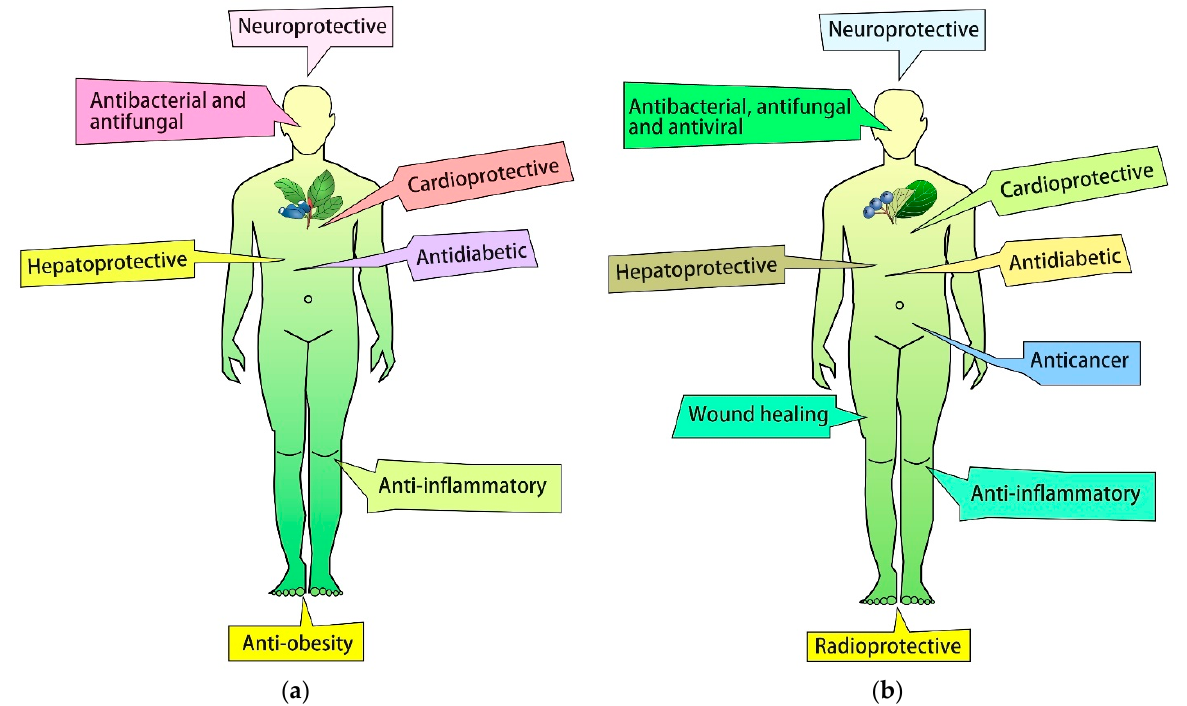
Figure 5. Pharmacological effects of L. caerulea ( a ) and A. melanocarpa ( b ).